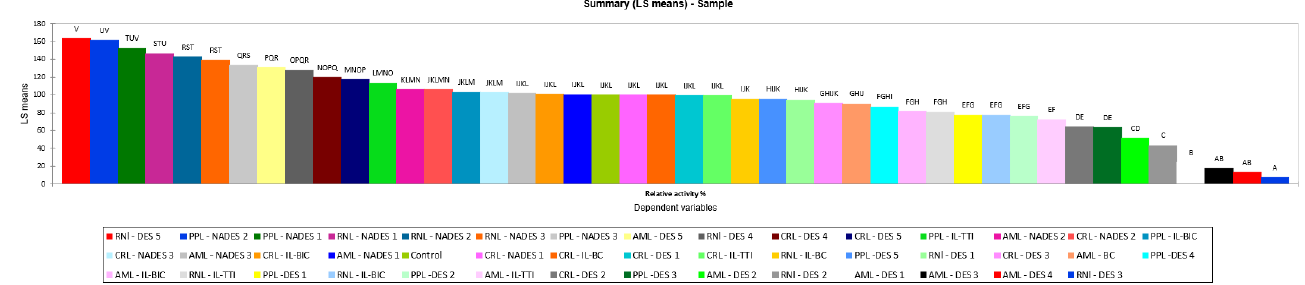
Figure 5. Summary of the least square means of all lipases (CRL, AML, RNL, and PPL) with different types of NADESs/DESs. CRL = Candida rugosa lipase, ≥ 700 U mg − 1 solid, AML = Amano lipase PS, from Burkholderia cepacian , ≥ 30,000 U g − 1 ), RNL = Rhizopus niveus lipase, ≥ 1.5 U mg − 1 ), and PPL = porcine pancreas lipase, 100 – 500 U mg − 1 protein.